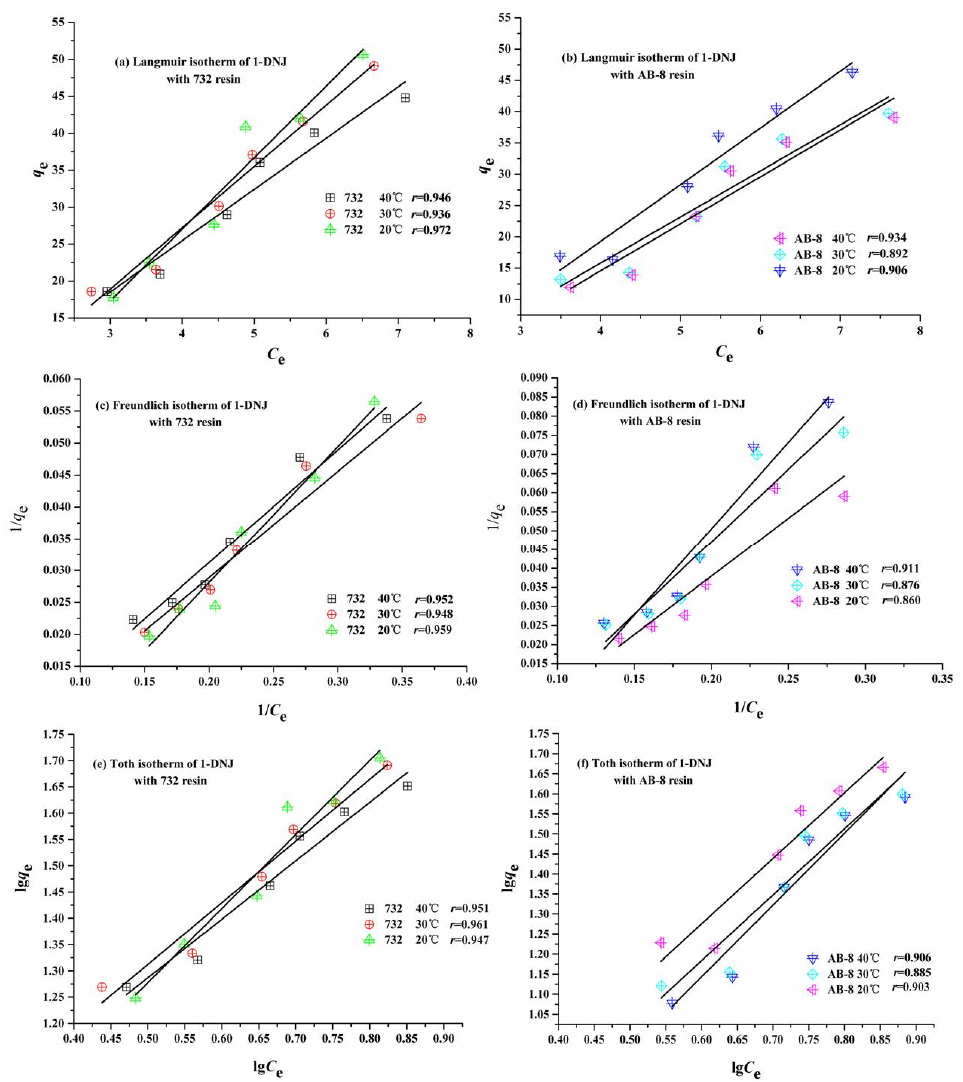
Figure 4. The adsorption isotherms of 1-DNJ with 732 and AB-8 resins at different